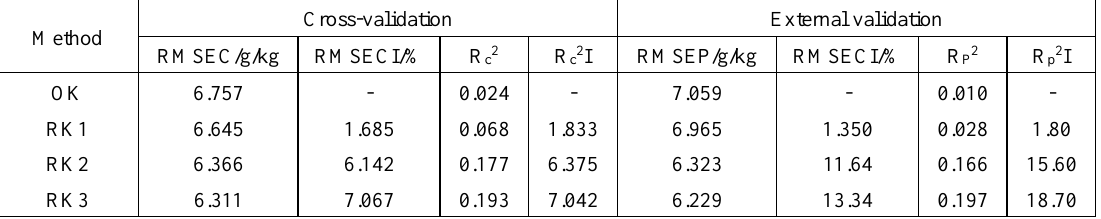
Table 6 Evaluation of prediction accuracy of four models